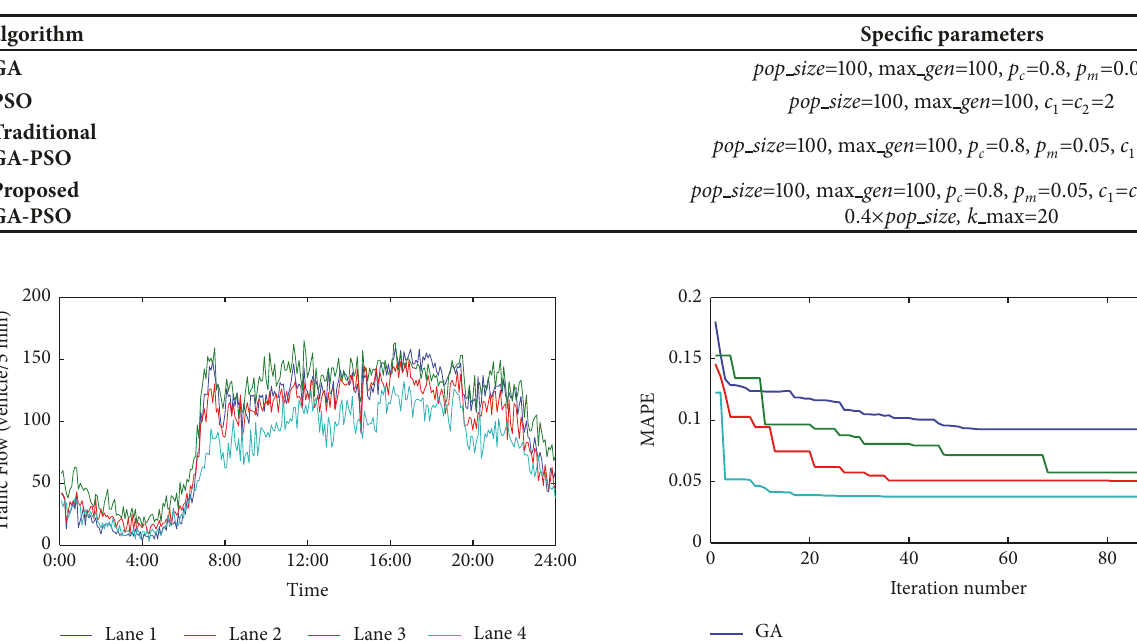
Table 2: Specific parameters of different algorithms.